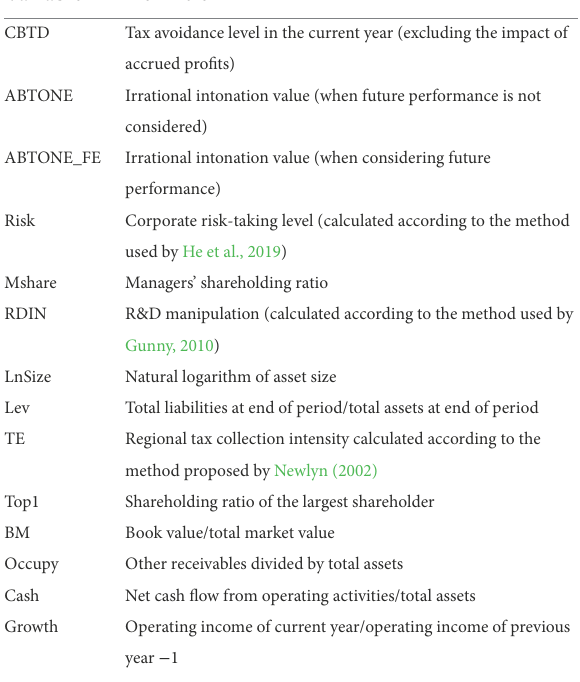
TABLE 1 Definitions of primary